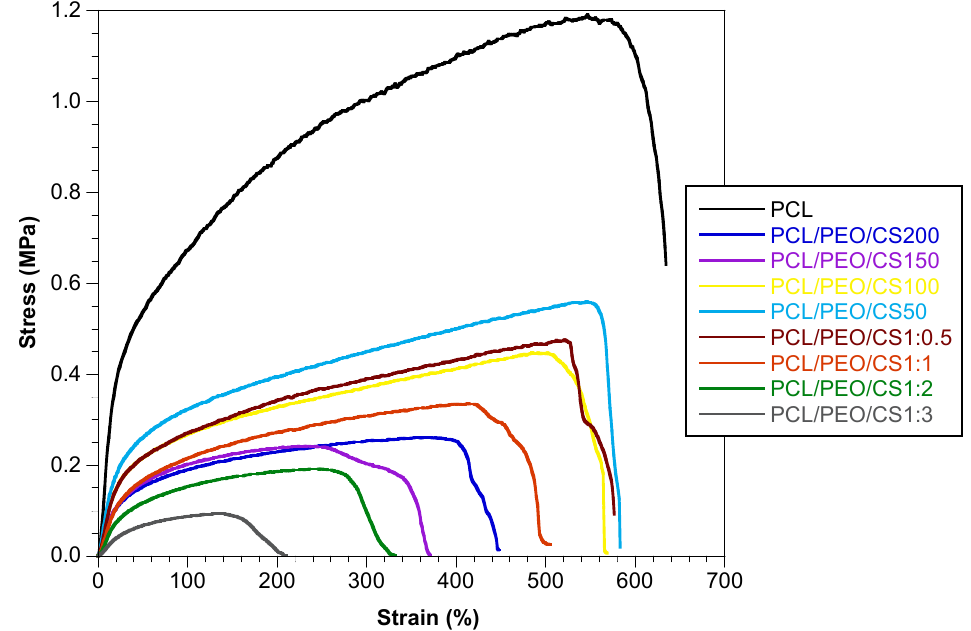
Figure 6. Representative stress–strain curves of PCL mats and PCL mats with CS flakes of different sizes and different PCL/CS mass ratios. sizes and different PCL/CS mass